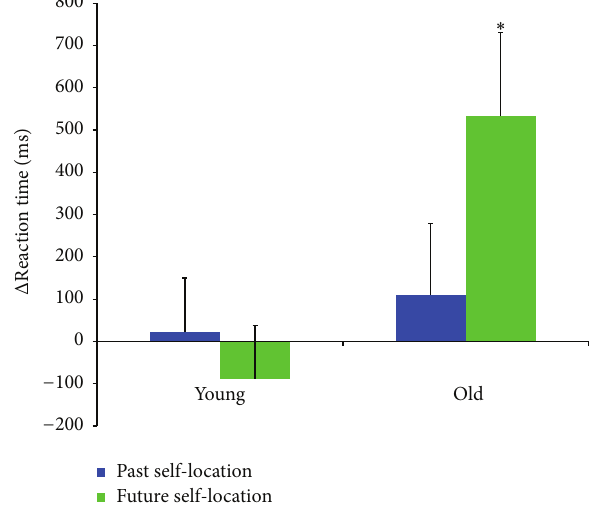
Figure 3: Group × Self-location interaction on Δ RTs. Values are in ms and error bars depicted SEM. Asterisk indicates significant differences ( 𝑝 < 0.05